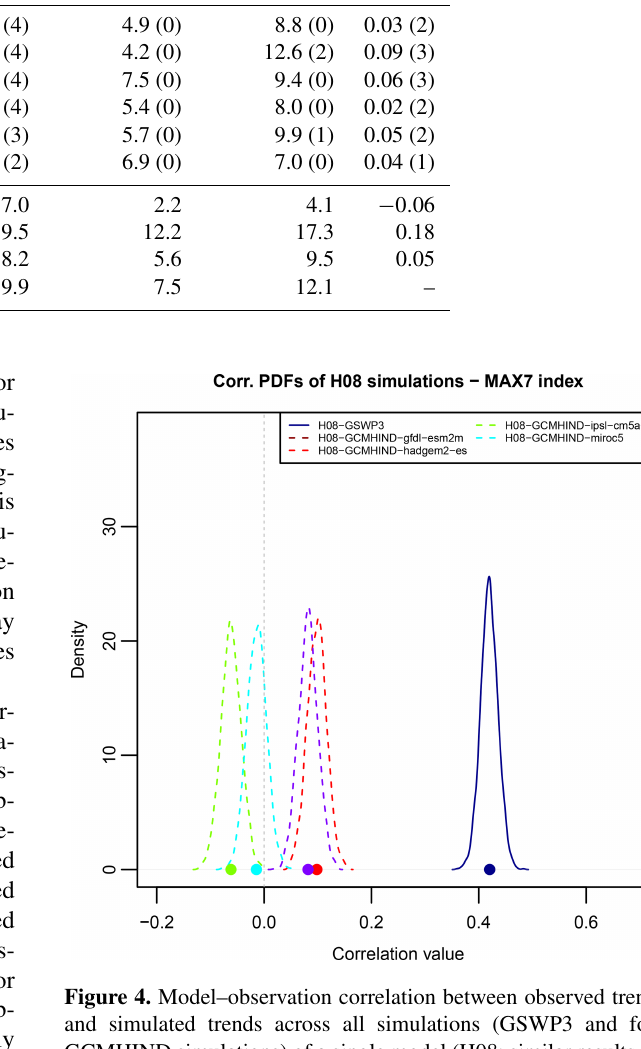
(Oceania) to 2.4 % change per decade (Europe), while trend standard deviation ranges from 8.3 % (Europe) to 15.8 % change per decade (Oceania). The percentage of significant increasing (decreasing) trends exhibited from GSIM ranges from 3.2 % to 22.6 % (from 6.3 % to 29.1 %), and the